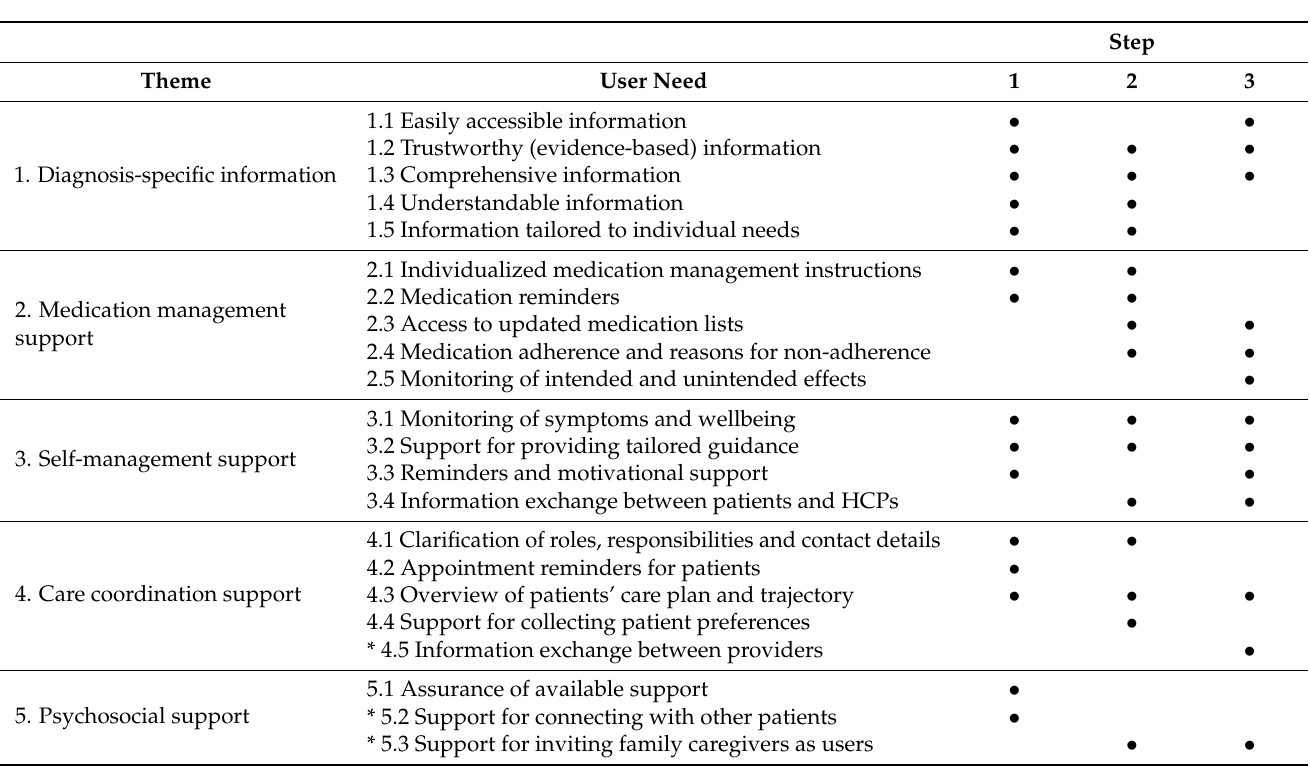
Table 2. Identified user needs grouped into five themes. Steps 1–3 indicate in which data collection steps the needs were